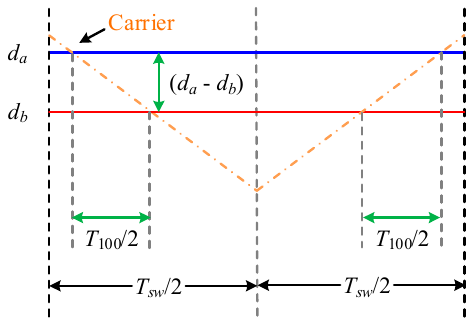
Figure 10. Relationship between the pulse width and duty ratio difference.